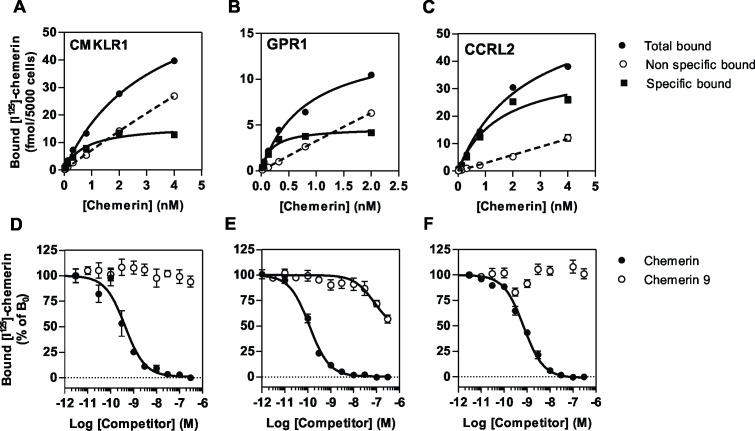
Chemerin binding assay.A-C. Saturation binding assay using CHO-K1 cells expressing CMKLR1 (A), GPR1 (B) or CCRL2 (C) that were incubated with increasing concentrations of [125I]-chemerin (total binding, ●). Non-specific binding (◯) was determined in the presence of a 100-fold excess of unlabeled chemerin and specific binding (■) was calculated as the difference. D-F. Competition binding assay using CHO-K1 cells expressing CMKLR1 (D), GPR1 (E) or CCRL2 (F) that were incubated with 0.1 nM [125I]-chemerin as tracers and increasing concentrations of unlabelled chemerin (●) or the nonapeptide chemerin 9 (◯) as competitors. The data were normalized for nonspecific binding (0%) in the presence of 300 nM chemerin, and specific binding in the absence of competitor (100%). The displayed data represent the mean ± S.E.M. of three independent experiments.